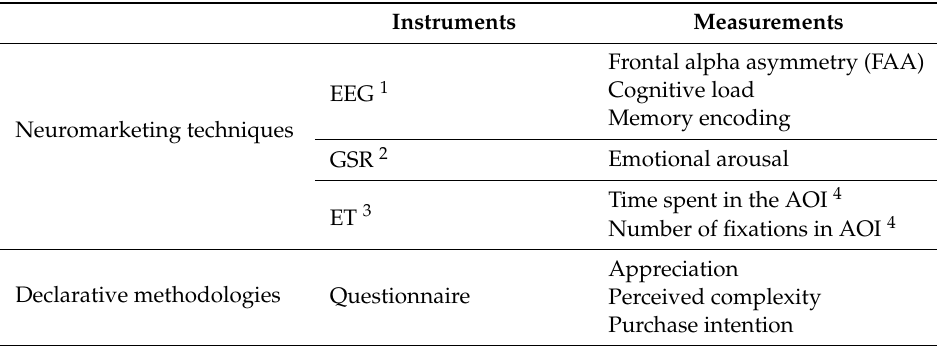
Table 1. Instruments and measurements. Instruments Measurements Frontal alpha asymmetry (FAA) Cognitive load EEG 1 Memory encoding Neuromarketing techniques GSR 2 Emotional arousal Time spent in the AOI 4 ET 3 Number of fixations in AOI 4 Appreciation Declarative methodologies Questionnaire Perceived complexity Purchase